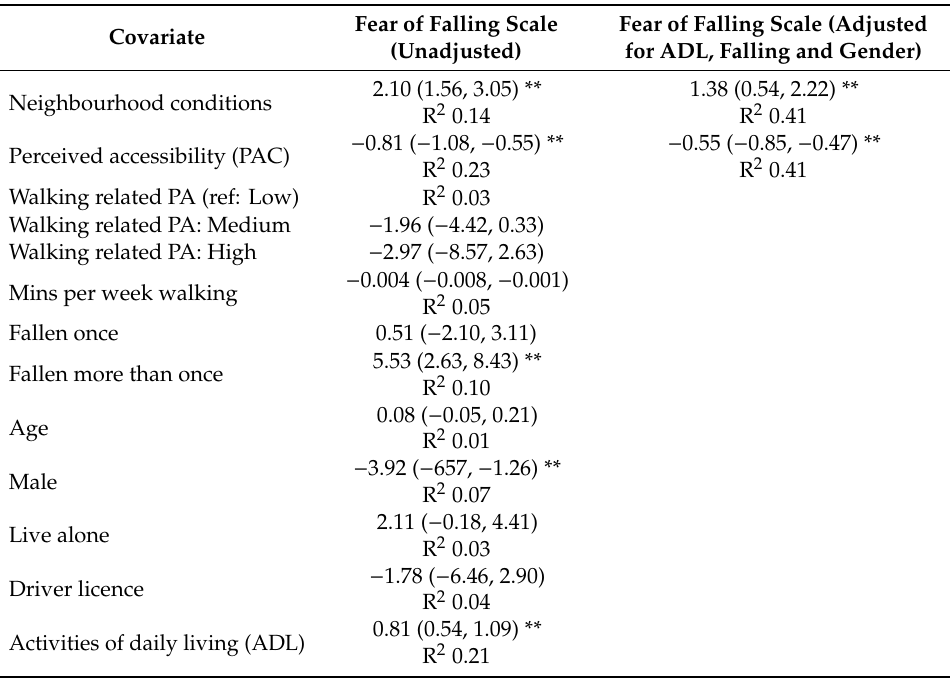
Table 4. Linear regression models—associations with fear of falling scale. Fear of Falling Scale Fear of Falling Scale (Adjusted Covariate (Unadjusted) for ADL, Falling and